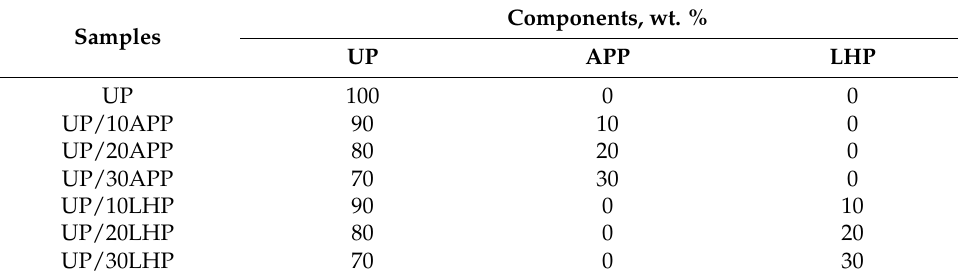
Table 6. Formulations of flame retardancy unsaturated polyester resin (UP).